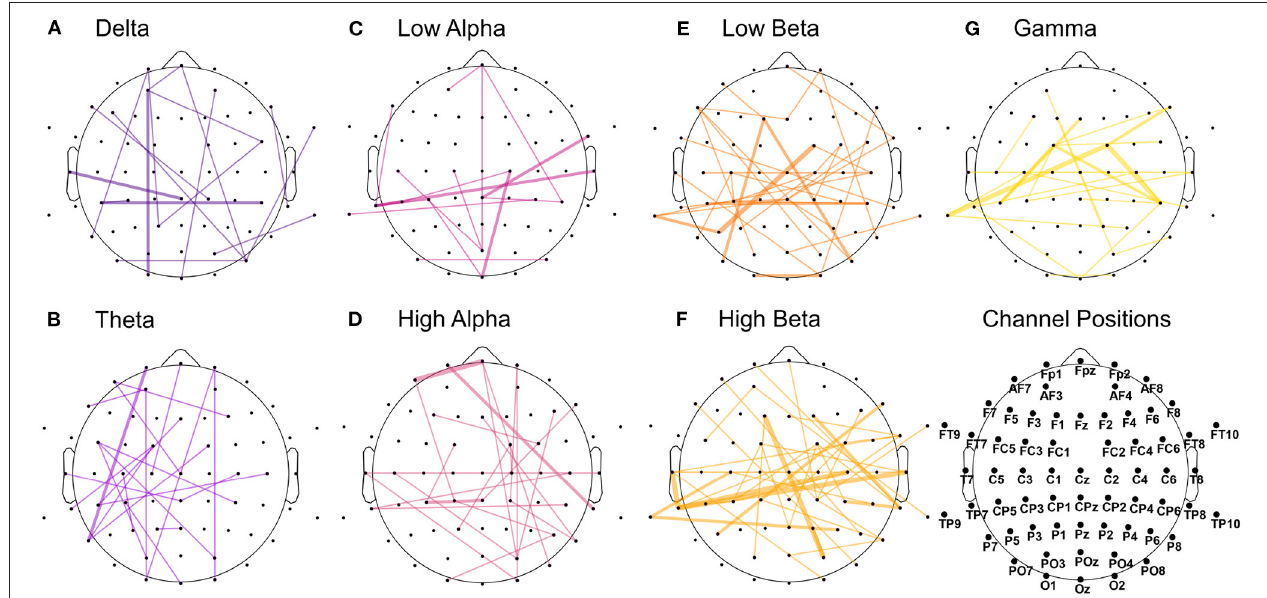
FIGURE 6 | Features with the highest significance in distinguishing the emotional states from the amplitude time-series correlation analysis. The analysis was carried out across participants, with 220 features in total (20 per participant). The graph plots are separated into the seven extracted frequency bands, from delta (dark violet) to gamma (yellow). The connection’s width reflects how often the correlation occurred in the main features across participants, with the thicker line representing higher occurrence across subjects. (A) Delta. (B) Theta. (C) Low alpha. (D) High alpha. (E) Low beta. (F) High beta. (G)